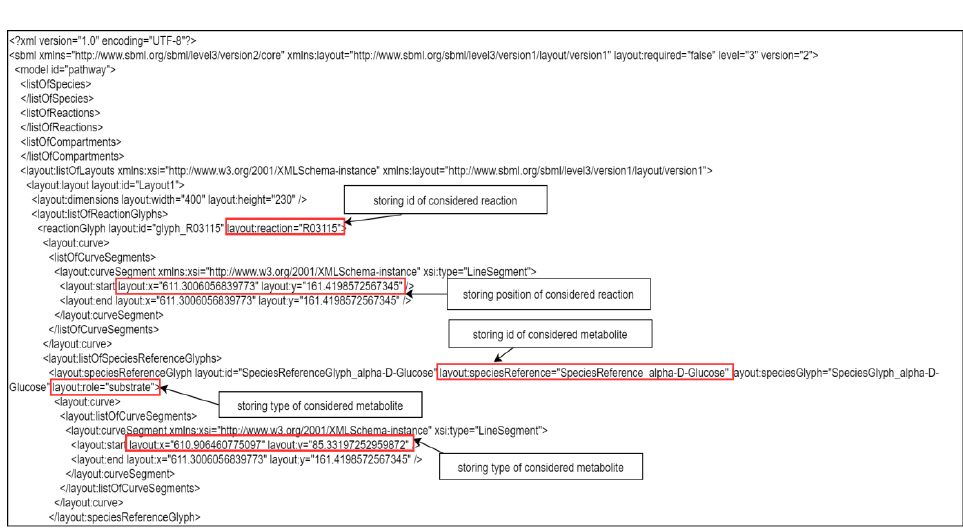
Figure 6. An example of updates in an SBML file. In the tag ‘layout:listOfLayouts’ , all positions for the nodes of the created pathway are stored.